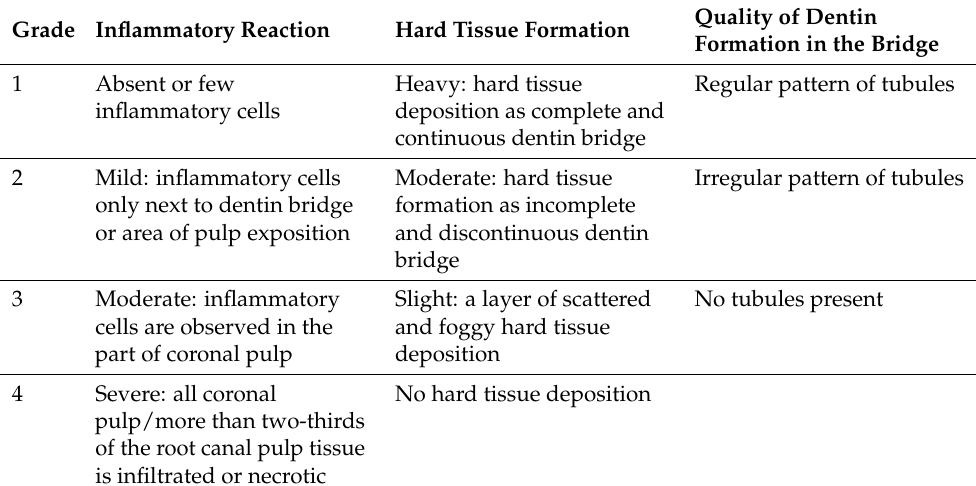
Table 1. The scoring system used to evaluate the pulp response to direct pulp capping